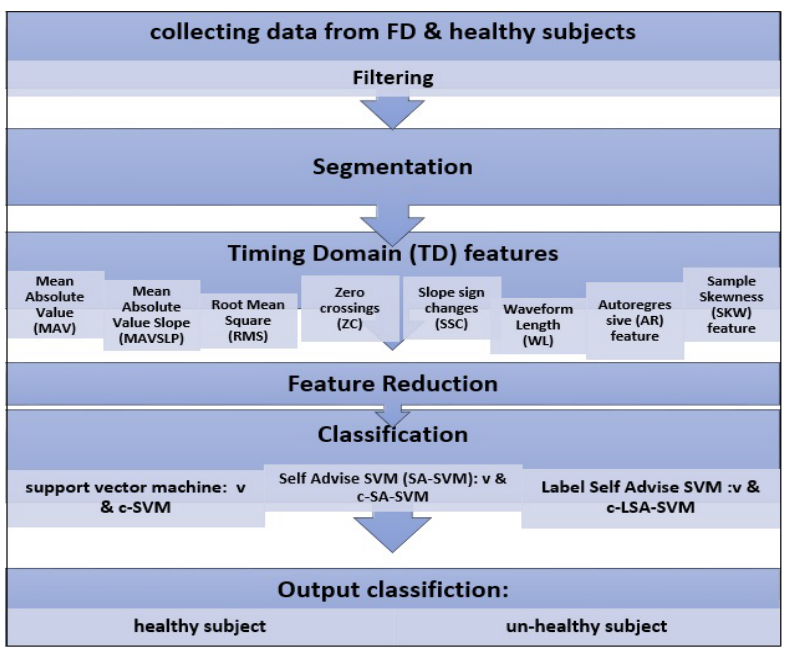
Figure 12. Flowcharts for each stage of